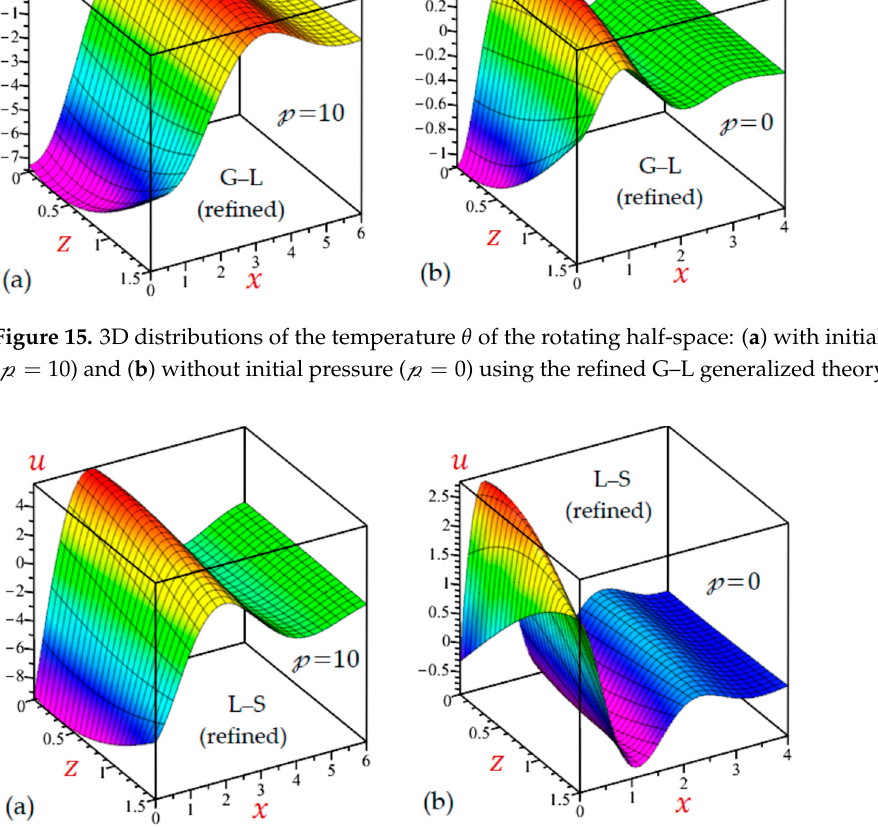
Figure 16. 3D distributions of the horizontal displacement u of the rotating half-space: ( a ) with initial pressure ( (cid:112) = 10) and ( b ) without initial pressure ( (cid:112) = 0) using the refined L–S generalized theory.